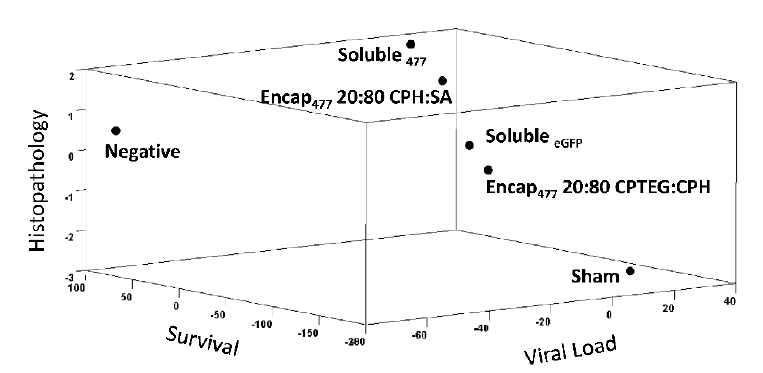
Figure 6. Principal component analysis of viral load, survival, and histopathology. Principal component analysis was used to determine the effects of nanovaccines on key vaccine efficacy parameters: survival, viral load, and histopathology postchallenge. The results were plotted three dimensionally and the similarity among formulations is defined through the comparison of Euclidean distances, where formulations in close proximity to one another represent greater similarity.